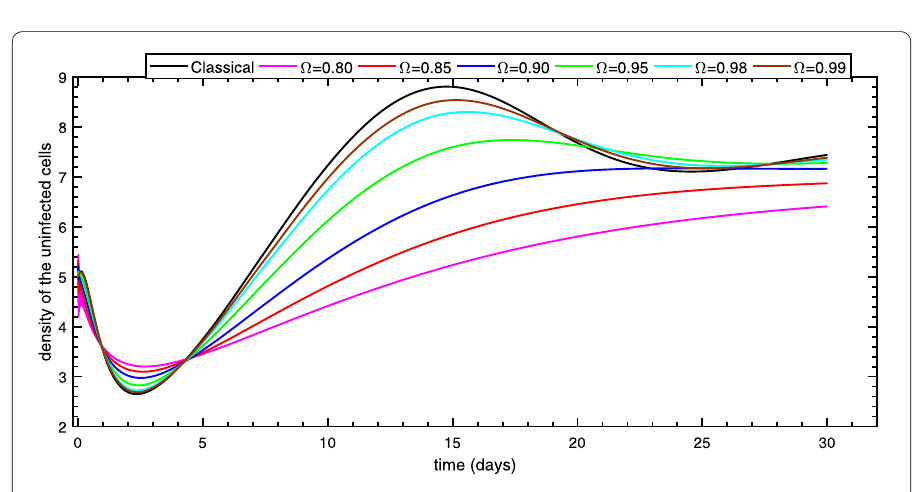
Figure 2 Density of the uninfected cells with initial conditions X (0) = 5, Y (0) = 20, V (0) = 0 for t ∈